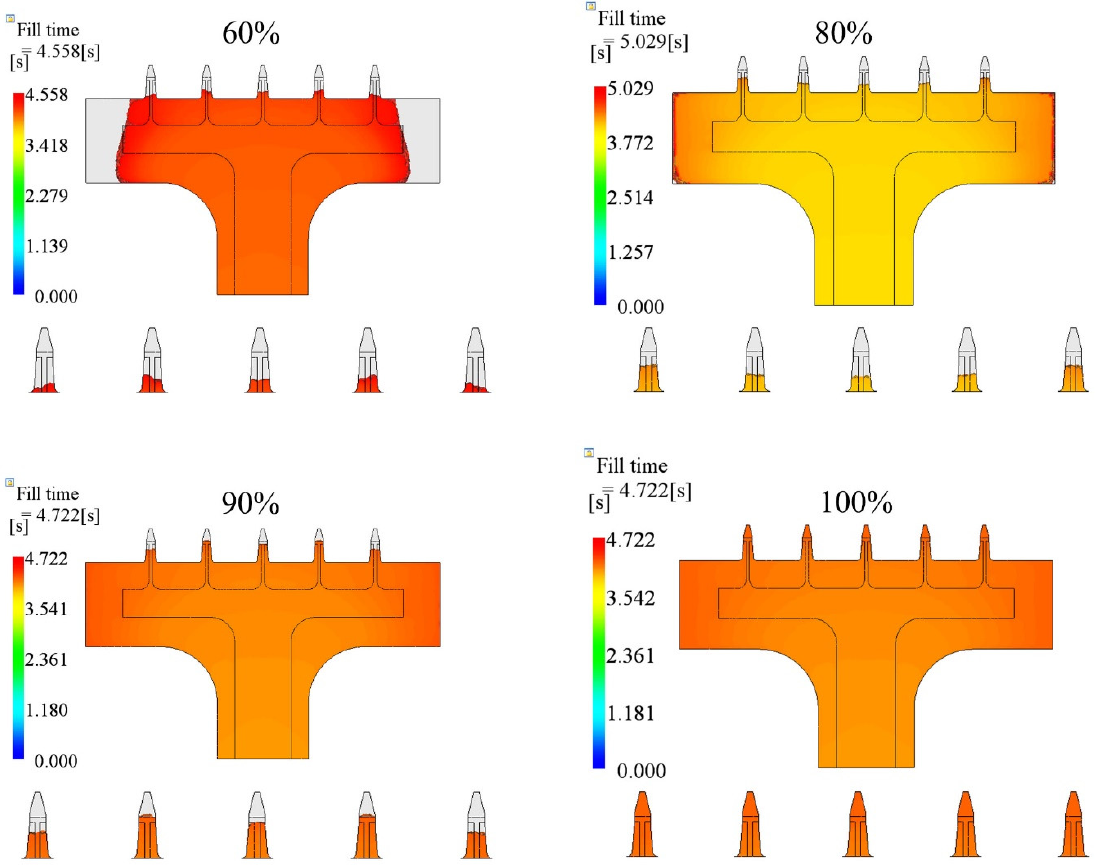
Figure 10. Filling contours for different packing pressure cases. The packing pressure was changed from 60% to 100% of the final filling pressure.